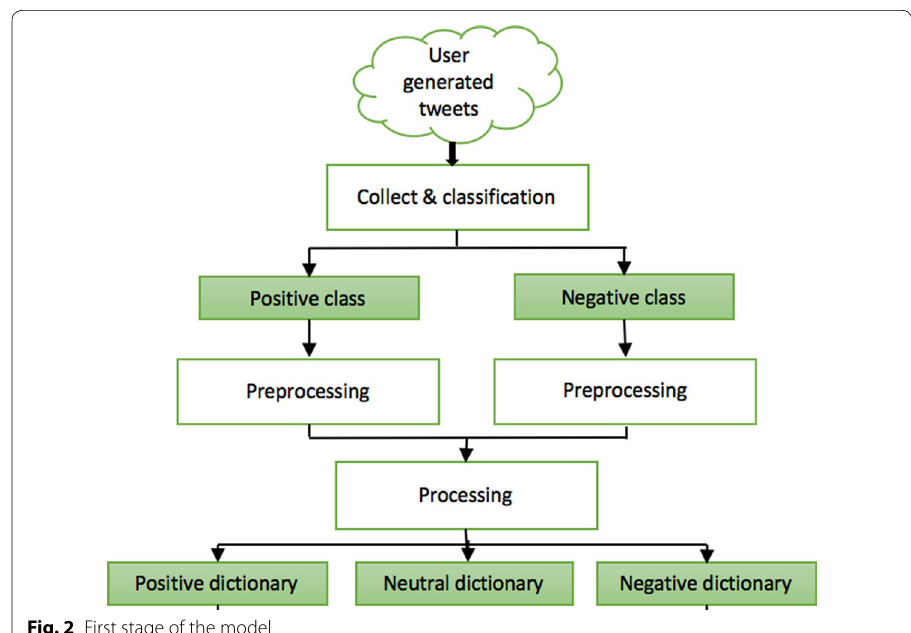
Fig. 2 First stage of the